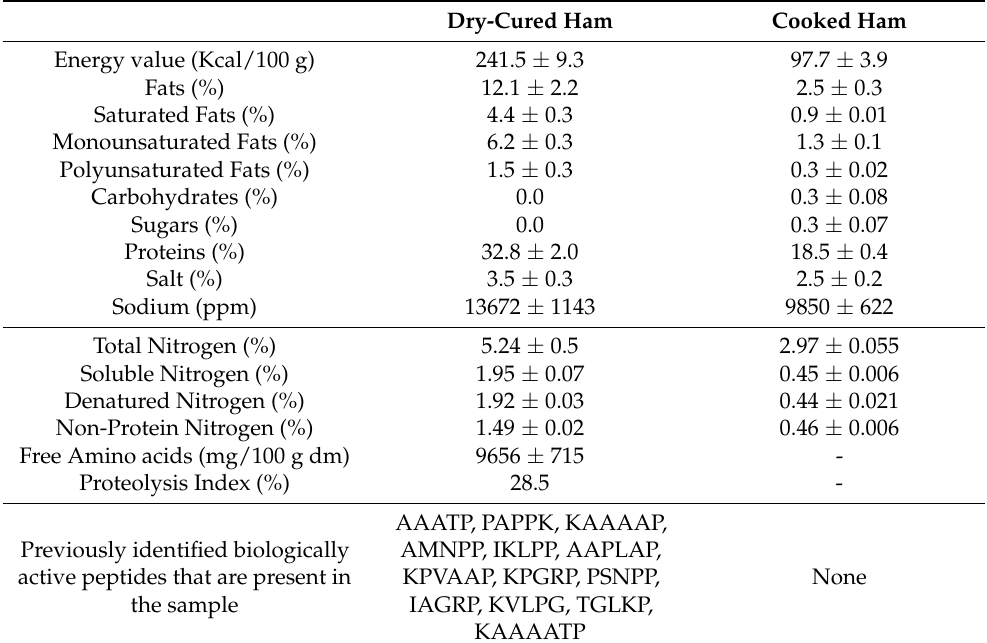
Table 1. Nutritional composition and total content of active peptides of interventional and placebo- control meat